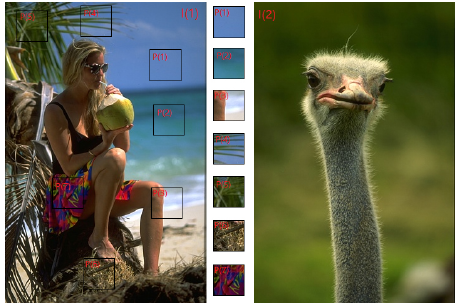
Figure 1. Image patches (from P(1) to P(7) in image I(1)) have diverse color and density layout and the same between I(1) and